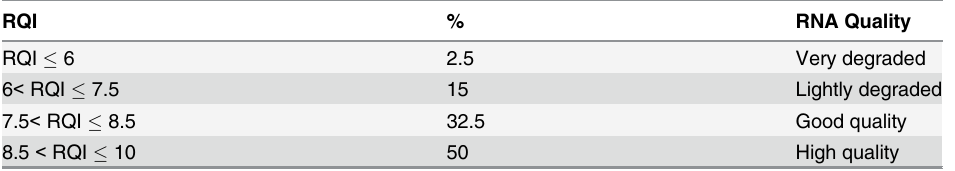
Table 1. RNA integrity and quality. RNA quality indicator (RQI) for hippocampal slices and percentage of samples for each RQI value range.